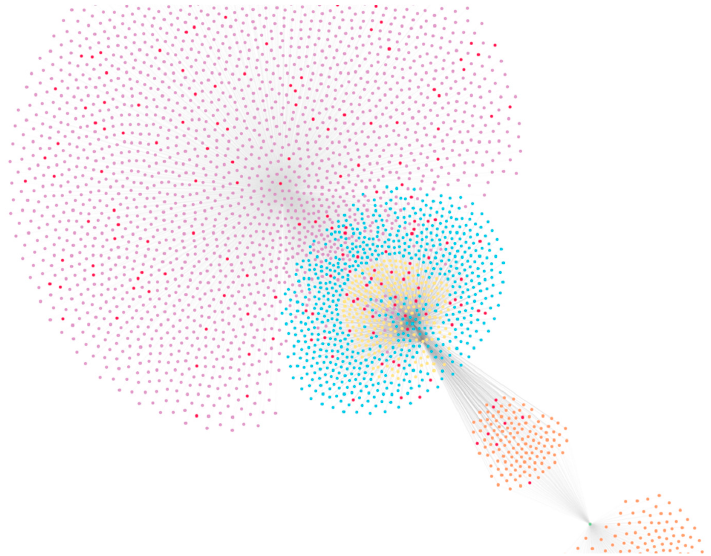
Figure 4. An example of the different communities using the community detection algorithm.